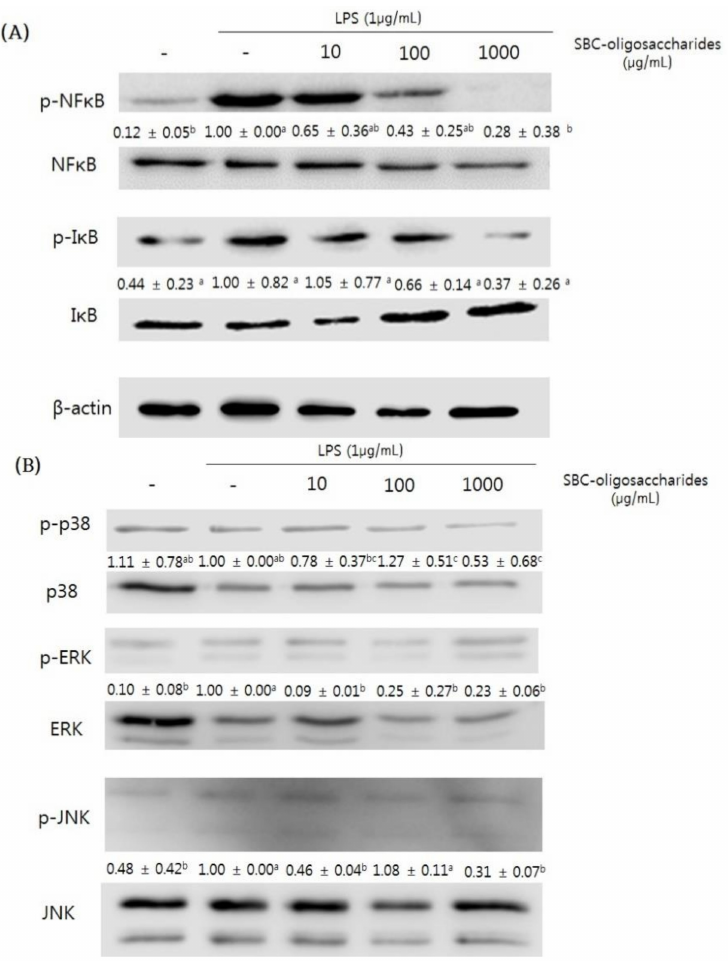
Figure 8. Effects of the oligosaccharides produced by Leu. lactis SBC001 on the nuclear factor- kappa B (NF- κ B) signaling pathway and MAPK signaling pathways in RAW 264.7 cells. RAW 264.7 cells were pretreated with oligosaccharides for 1 h and then treated with 1 µ g/mL LPS for 24 h. ( A ) Western blot images for the expression of genes in the NF- κ B signaling pathway. ( B ) Western blot images for the expression of genes in the MAPK signaling pathways. One-way ANOVA was used for the comparison of group mean values, followed by Duncan’s multiple range test for assessing the significance of individual comparisons ( p < 0.05) (n ≥ 3). Different letters represent significant differences among groups. The numbers between blots indicate the relative expression